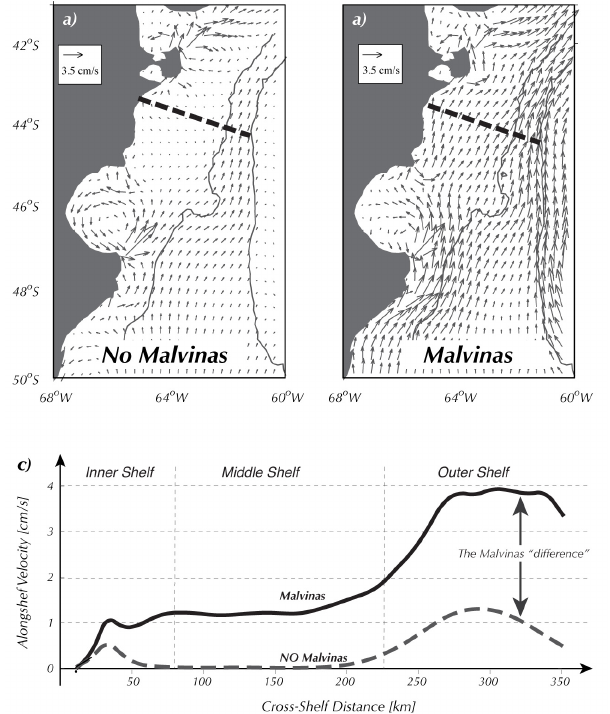
Fig. 9. (a) Depth averaged velocities in EXP2; (b) EXP1; (c) Alongshelf velocities across the section shown in the upper pan- els. The differences between these two experiments are mainly due to the